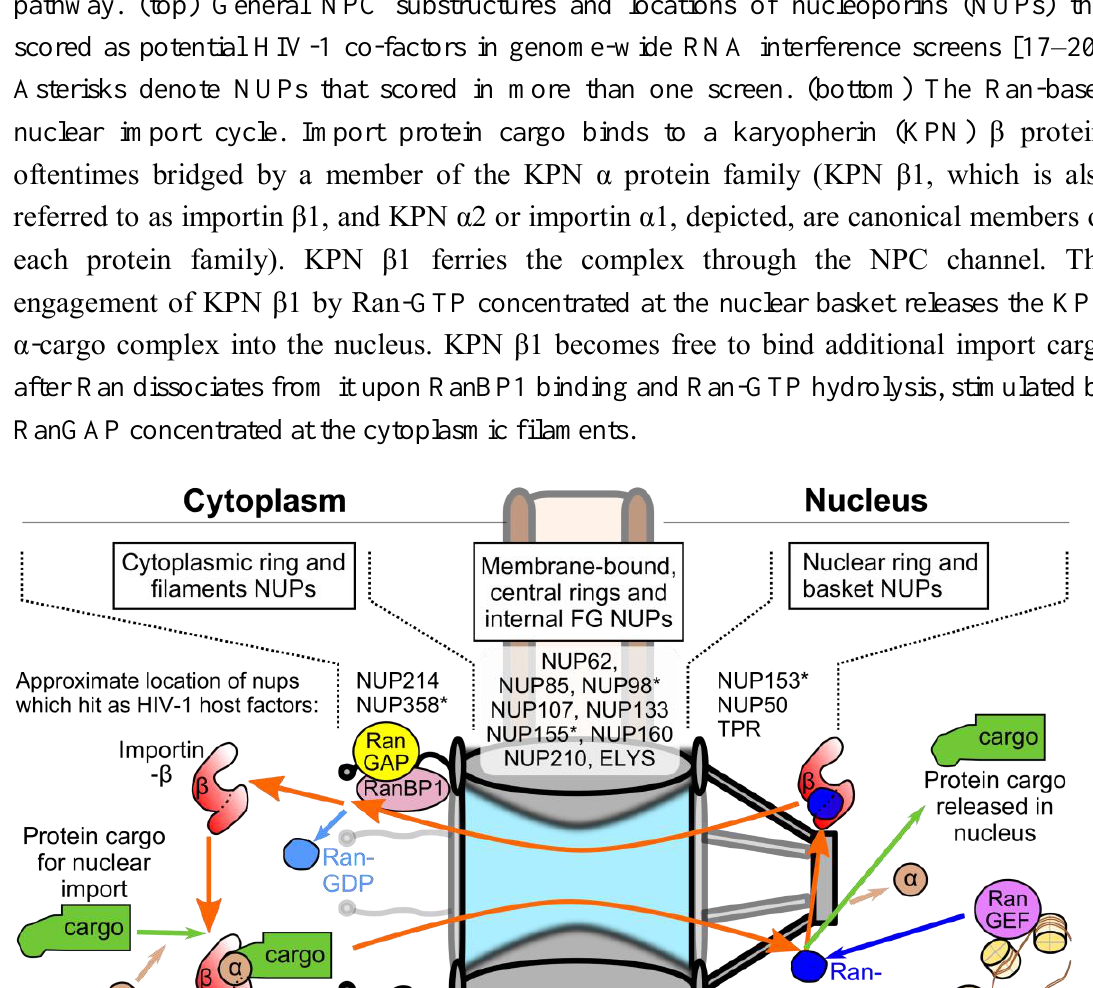
Figure 1. Schematic of the nuclear pore complex (NPC) and classical nuclear